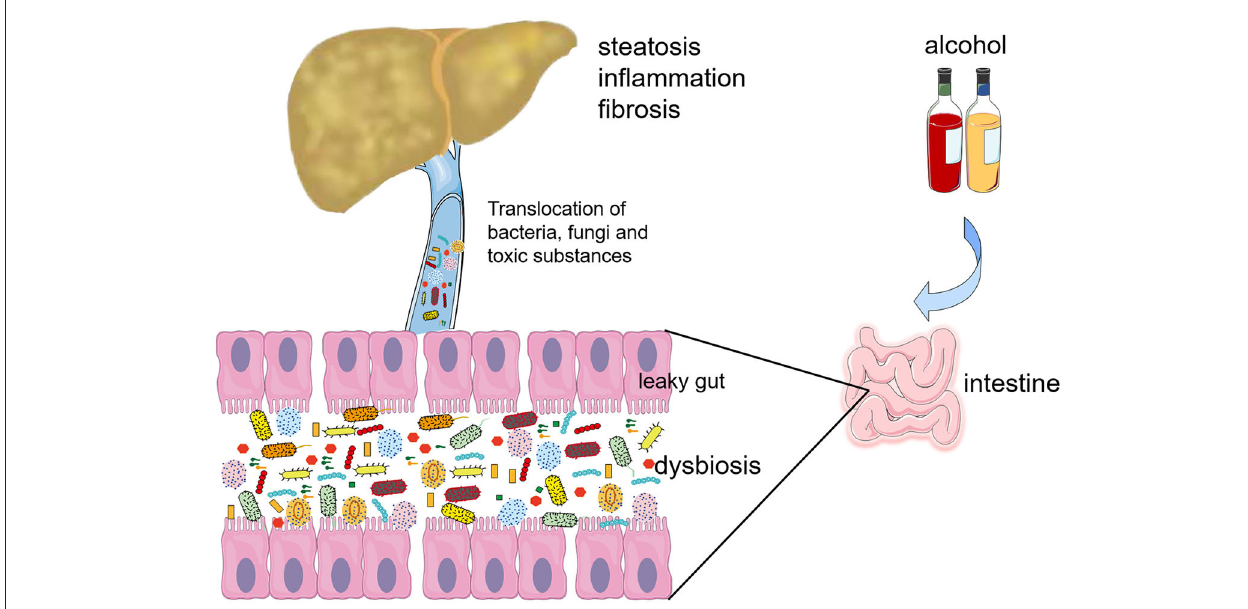
FIGURE 1 | Gut-liver cross talk in alcohol-associated liver disease (ALD). Alcohol induces the gut dysbiosis, mainly manifested as changes in the quantitative and qualitative of intestinal microbiota and fungi. The oxidative and non-oxidative metabolites of ethanol and gut dysbiosis all destroy the intestinal barrier. Gut-derived bacteria, fungi and their toxins, such as lipopolysaccharide (LPS) and β -glucan translocate into the liver though the damaged intestinal barrier and promote the progression of inflammation and fibrosis of